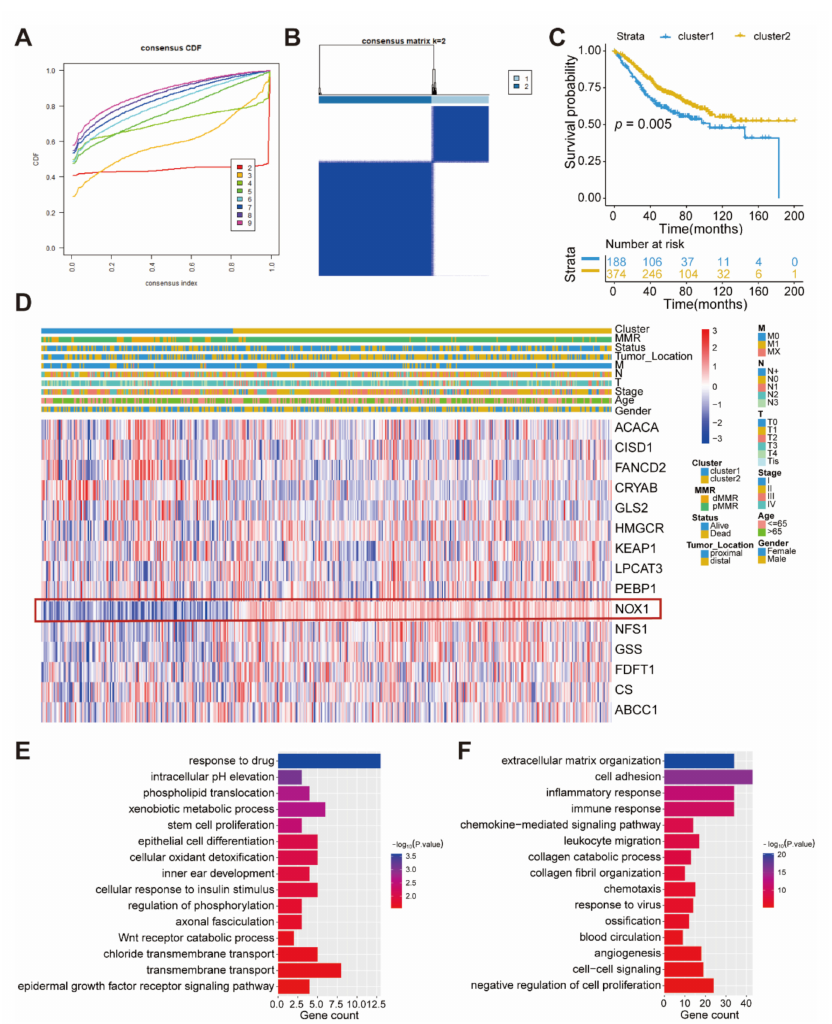
Figure 2. The characteristics of two molecular subgroups of colon cancer. ( A ) The cumulative function (CDF) curves in consensus cluster analysis. CDF curves of consensus score by different subtype numbers (k = 2–9) are represented. ( B ) The consensus matrices of the GSE39582 for k = 2. ( C ) Survival analyses for two molecular subgroups of colon cancer based on 562 patients with colon cancer from the GEO cohorts (GSE39582) including 188 cases in cluster1 and 374 cases in cluster2. Kaplan–Meier curves with Log-rank p value 0.005 showed a significant survival difference within two molecular subgroups of colon cancer. ( D ) Unsupervised clustering of 15 ferroptosis-related genes in the GSE39582. The cluster, stage, status, M, N, T, age, and gender were used as patient annotation. Red represents high expression of regulators and blue represents low expression. ( E ) Functional annotation for up expression in cluster2 using GO enrichment analysis. ( F ) Functional annotation for down expression in cluster2 using GO enrichment